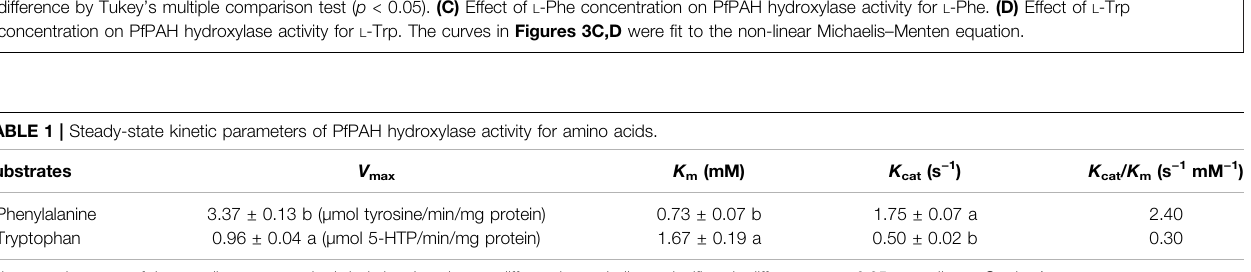
Values are the mean of three replicates ± standard deviation. In columns, different letters indicate signi fi cantly different at p < 0.05 according to Student ’ s t